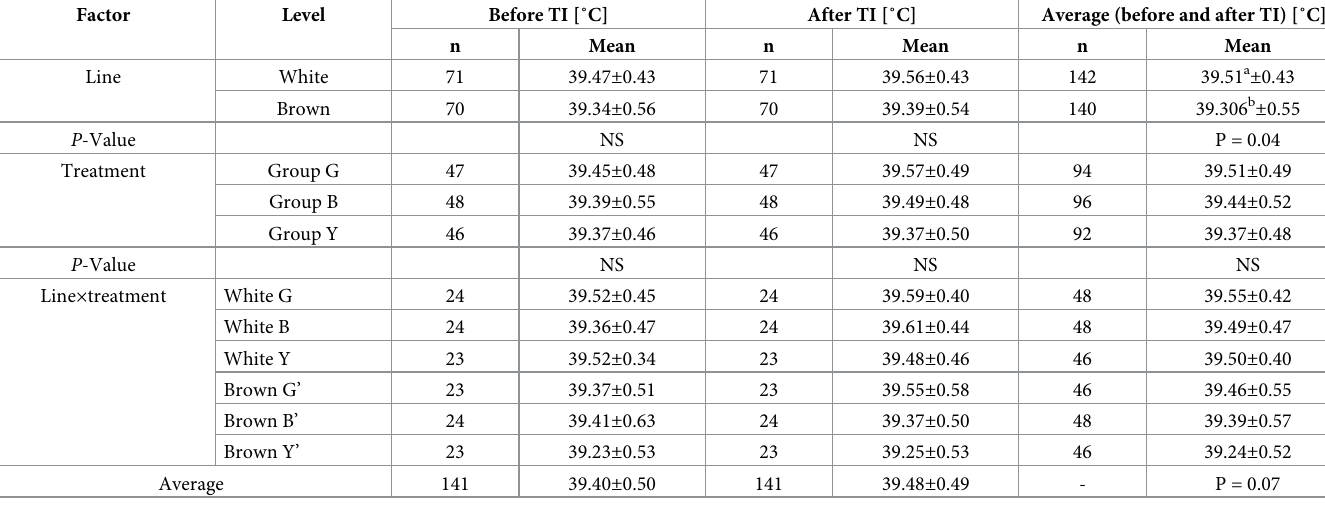
Table 4. Means and standard deviations for individual factors for the maximum temperature of the right face (RF). Factor